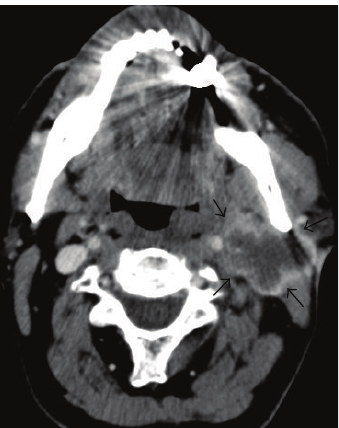
Figure 2: Axial postcontrast CT image of the neck showing left lym- phadenopathy with necrotic center and peripheral enhancement.